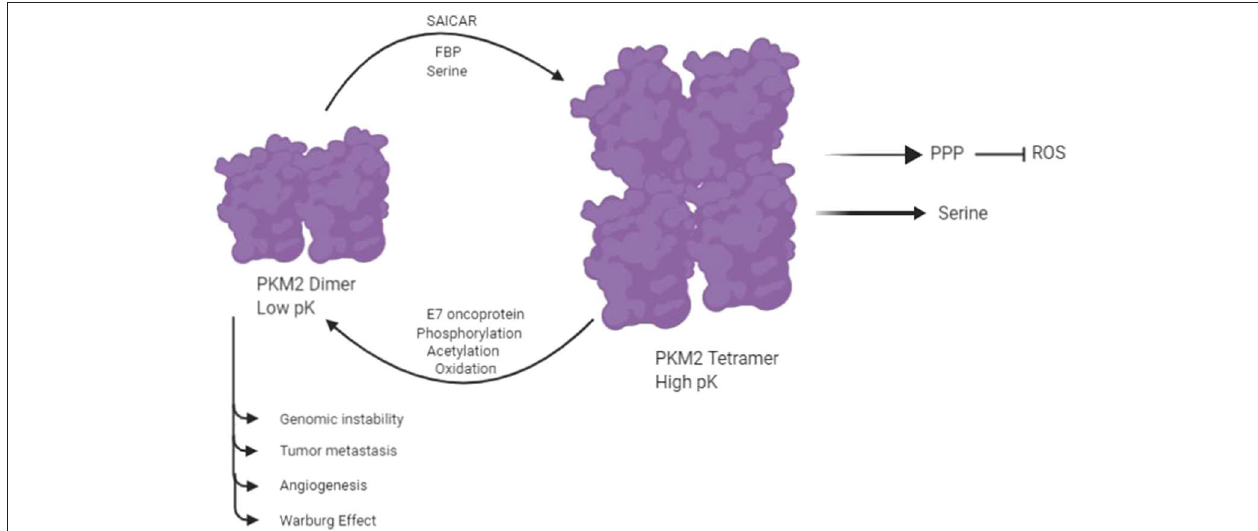
FIGURE 2 | PKM2 exists in two isomeric forms: a highly active tetramer and a low-activity dimer, whereas PKM1 constitutively exists only as a highly active tetramer. Several molecules control the switching between the dimeric and tetrameric forms of PKM2. E7 oncoproteins, tyrosine kinase-mediated phosphorylation, acetylation, and oxidation encourage the formation of low-activity dimer PKM2. In contrast, fructose-1,6-P2, serine, and SAICAR promote the formation of highly active tetramer ( 18).